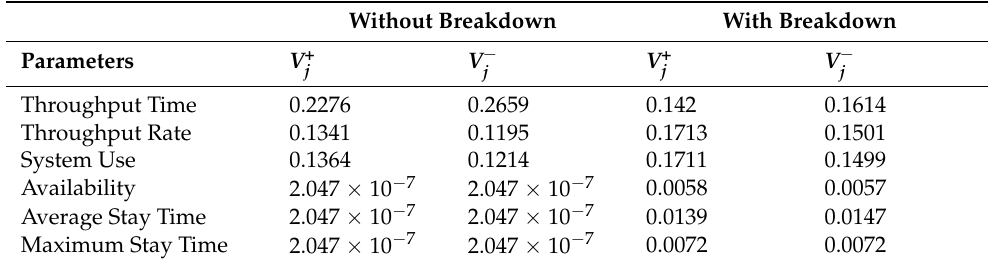
Table 14. Matrix of positive and negative ideal